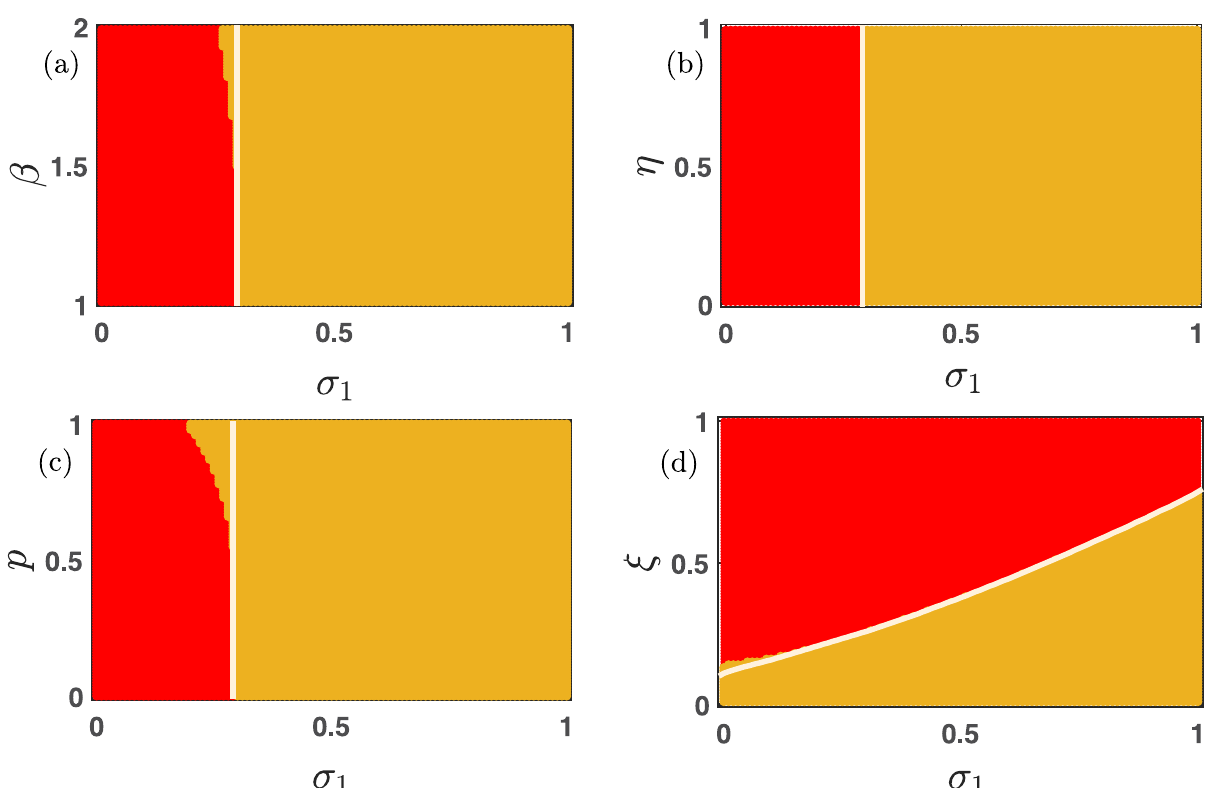
Fig 6. The effect of altruist free space on the nonlinear dynamics of multigames with mutation. The influence of free space-induced benefits by varying σ 1 within the closed interval [0, 1] is established. The whole population goes extinct in the red region, and the yellow area reflects the system’s stable interior point, corresponding to the coexistence of all two strategies. All the parameters are kept fixed at ξ = 0.25, η = 0.85, p = 0.30, σ 2 = 0.20, β = 1.1, μ = 0.5, unless it is varied. The initial condition is kept fixed at (0.35, 0.35). A notable difference is observed from (Fig 4), which is drawn in the absence of mutation. Larger values of σ 1 always facilitate the maintenance of cooperation, and the bidirectional mutation reinforces the system’s inherent tendency to flow from cooperators to defectors. The solid white line in each figure is the analytically computed stability curve corresponding to the extinction equilibrium.